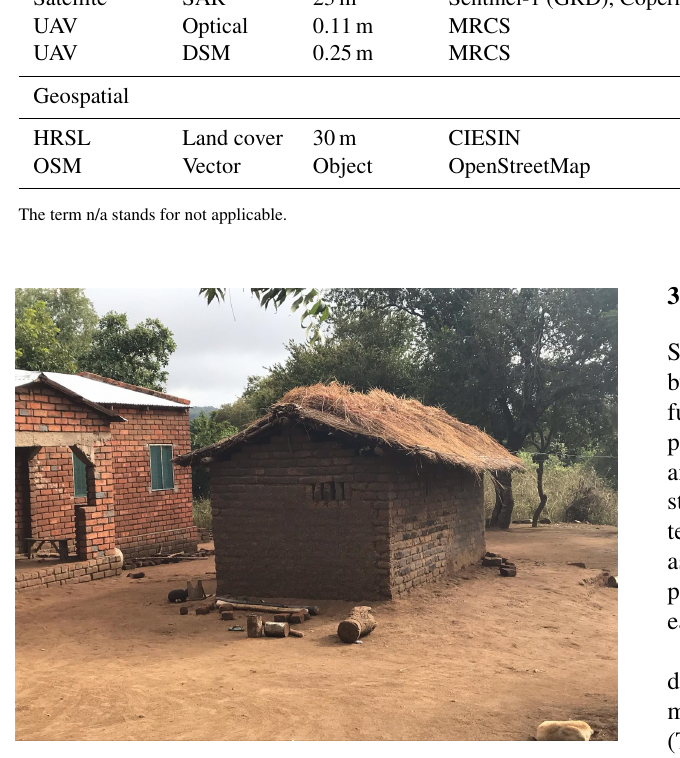
Figure 2. Image from one of the sample buildings taken in the case study area taken by T. Teule (23 June 2019). A clear con- trast between building material is visible between the two buildings: thatched roofs and unburned brick walls (middle building) versus iron sheeted roofs and burned brick walls (left